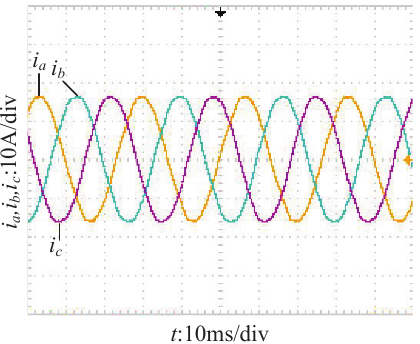
Figure 22. Steady-state current waveform when m = 0.6, D = 0.1.